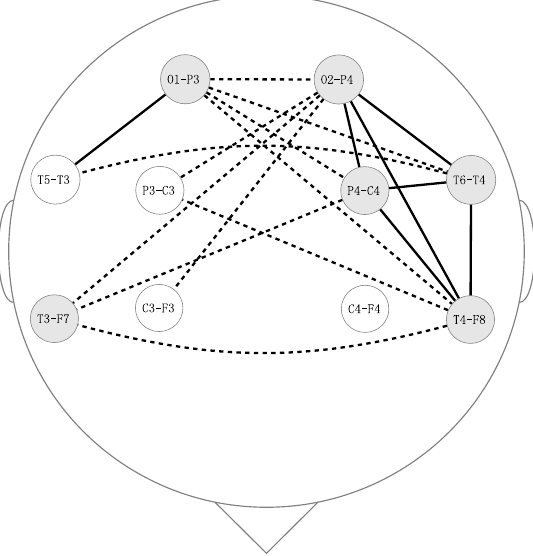
Fig. 2. Clusters and links where both criteria are full fi led. In- ter-hemispheric links are depicted with dashed lines, intra-hemisphe- ric links for both right and left hemispheres are depicted with sol- id lines. Bipolar location where clusters are de fi ned are fi lled in gray. We notice that two bilateral homologous areas appear: fron- to-temporal (T3-F7 and T4-F8) and occipito-parietal (O1-P3 and O2-P4) and two right hemisphere areas: temporal (T6-T4) and pari- eto-central (P4-C4). Table 4 Contribution of each variable to each dimension. The fi rst three variables are clinical ones (age, duration and EDSS). The follow- ing three: “inter”, “left” and “right” refer to inter-hemispheric, left and right averaged mutual information respectively and the last fi ve variables: “code”, “srt”, “pst” “ten36” and “F” refer to the score